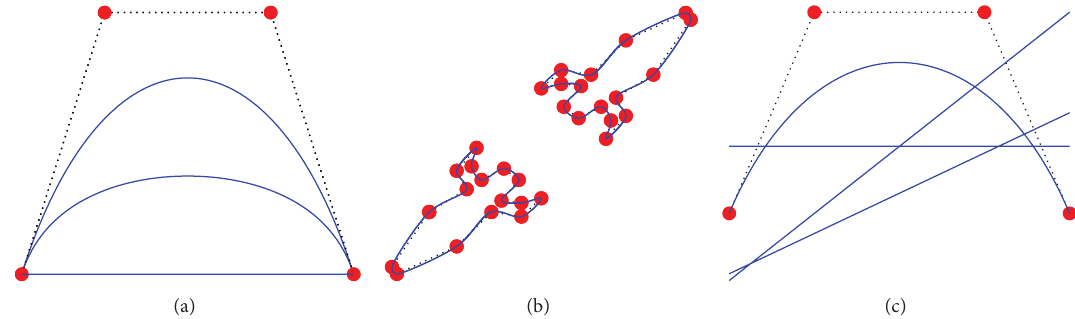
Figure 4: Rational cubic spline interpolant: (a) convex hull property; (b) affine invariance property; and (c) variation diminishing property.